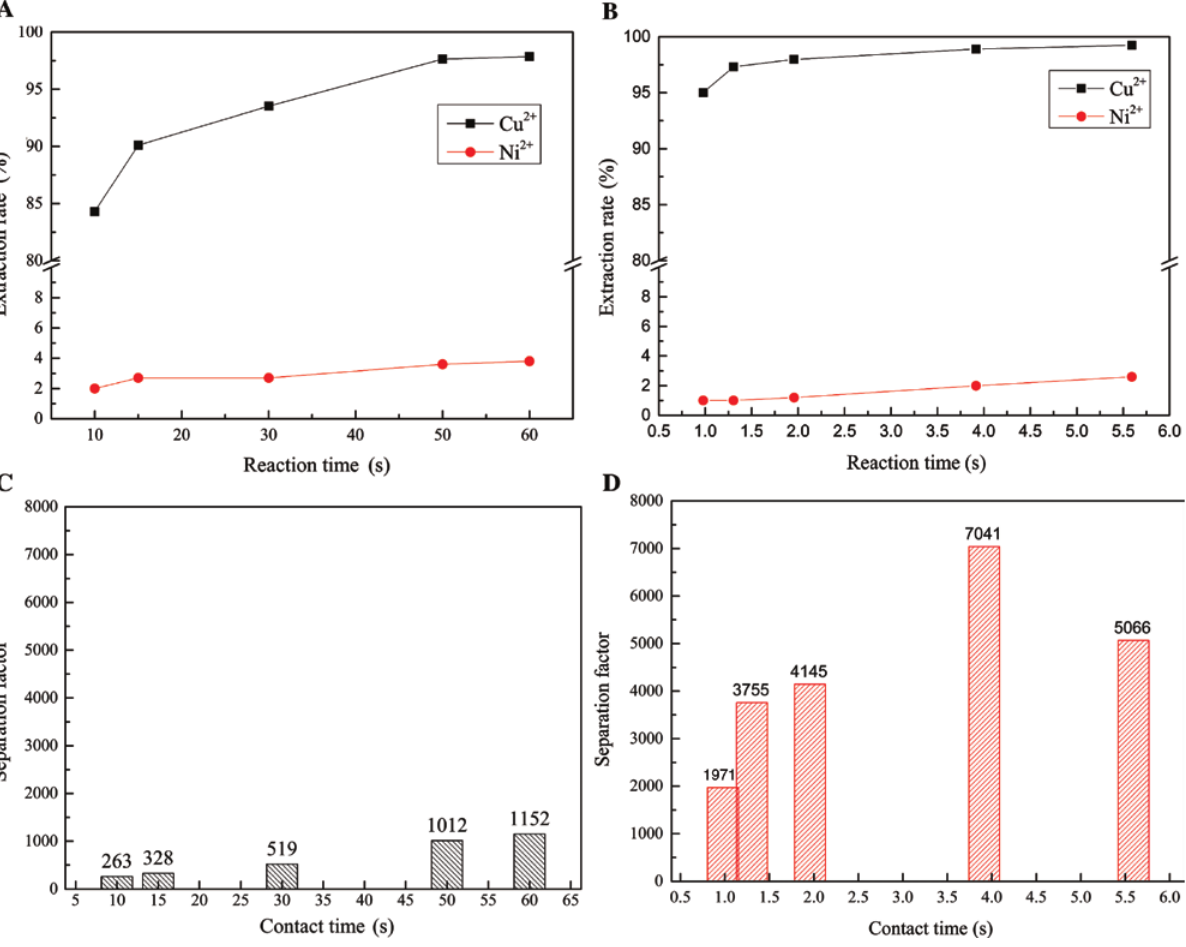
Figure 5: Effect of contact time on the extraction efficiency. (A) Extraction rate and (C) separation factor in separating funnel: initial pH = 2.5, oscillation frequency 300 rpm, volume fraction of extract- ant 15%; (B) extraction rate and (D) separation factor in microreactor: initial pH = 2.5, volume fraction of extractant 15%.